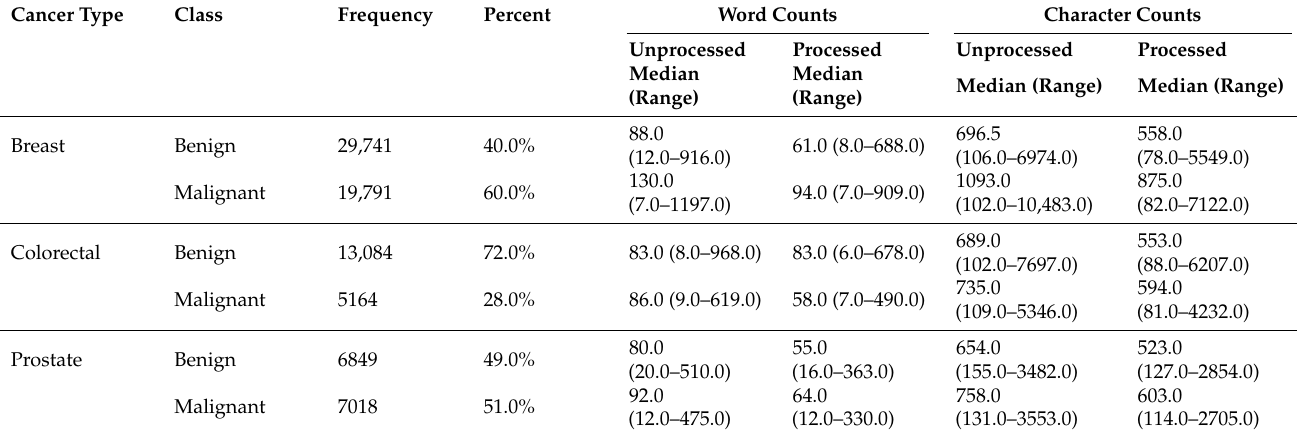
Table 1. Descriptive statistics of word counts and text length distribution for unprocessed and processed pathology reports across the three cancer